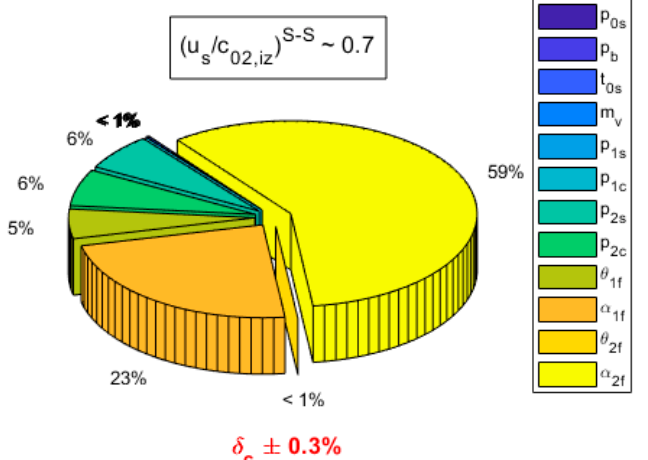
Figure 14. Bucket loss coefficient partial uncertainties diagram for operating mode ( u / c ∼ 0.7 ) at the mean radius.